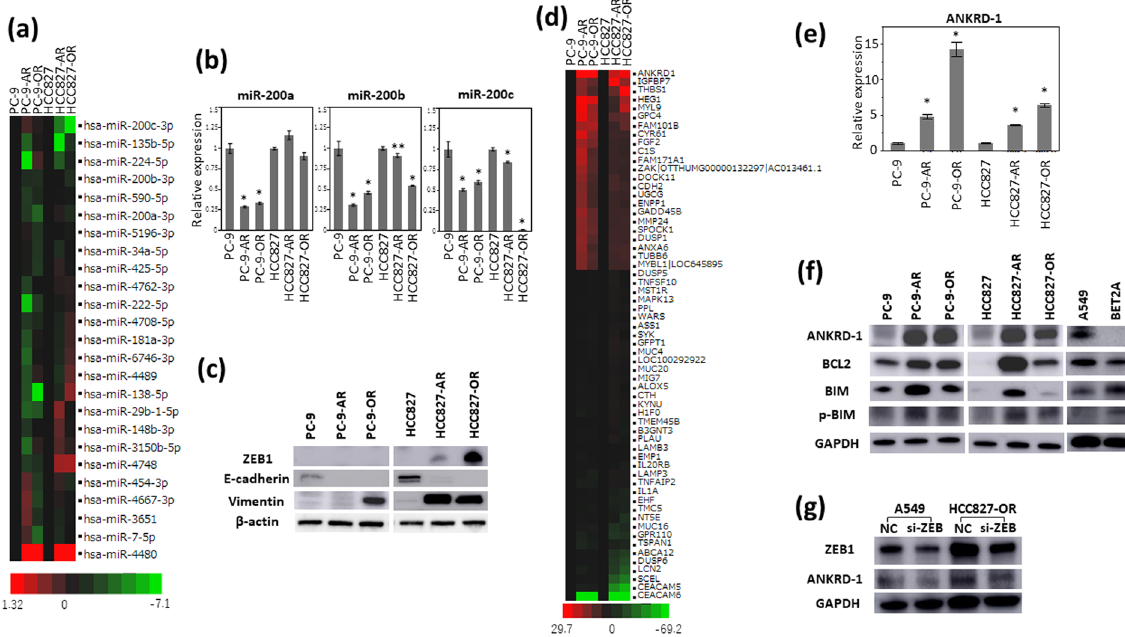
Figure 2. ANKRD1 overexpression the four EGFR-TKIs-resistant cell lines. ( a ) The miRNA microarray analysis showed that expression of the miR-200 family were downregulated in EGFR-TKIs-resistant cell lines. ( b ) The expression of miR-200a, miR-200b and miR-200c by qRT-PCR analysis. * p < 0.01, ** p < 0.05. ( c ) Protein expression of factors related to epithelial-mesenchymal transition. ( d ) cDNA microarrays showed gene expression profiles in the parental and four resistant cell lines. ( e ) qRT-PCR analysis showed overexpression of ANKRD1 in the resistant cell lines. * p < 0.01. ( f ) Upregulation of ANKRD1 proteins was shown by Western blotting analysis. ( g ) ZEB1 expression in A549 and HCC827-OR before and after siZEB1 transfection for 72 hours. The results of Western blotting analysis are shown. NC: siRNA negative